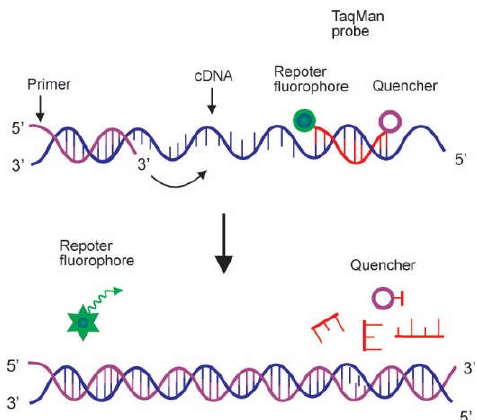
Figure 3. Mode of action of TaqMan probe. The TaqMan probe is a hydrolysis probe with a fluorescent reporter dye bound to its 5 (cid:48) end and a quencher dye at its 3 (cid:48) terminus. Whilst the probe is intact, fluorescence resonance energy transfer (FRET) occurs, and the fluorescence emission of the reporter dye is absorbed by the quenching dye. In the presence of the target sequence, the fluorogenic probe anneals downstream from one of the primer sites. It is cleaved by the 5 (cid:48) nuclease activity of the Taq polymerase enzyme during the elongation step of the real-time PCR. Cleavage of the probe by Taq polymerase during PCR segregates the reporter and quencher dyes, thereby producing a fluorescence signal (Adapted from Arya et al.